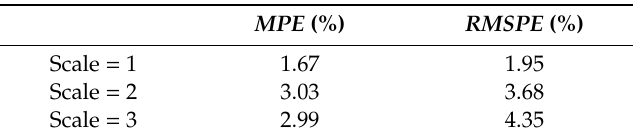
Figure 16. Estimation results using the multiscale sample entropy-based method. Table 3. The mean percentage error and root-mean-squared percentage error of the multiscale sample entropy-based